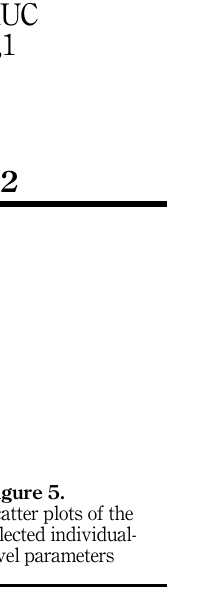
Figure 5. Scatter plots of the selected individual- level